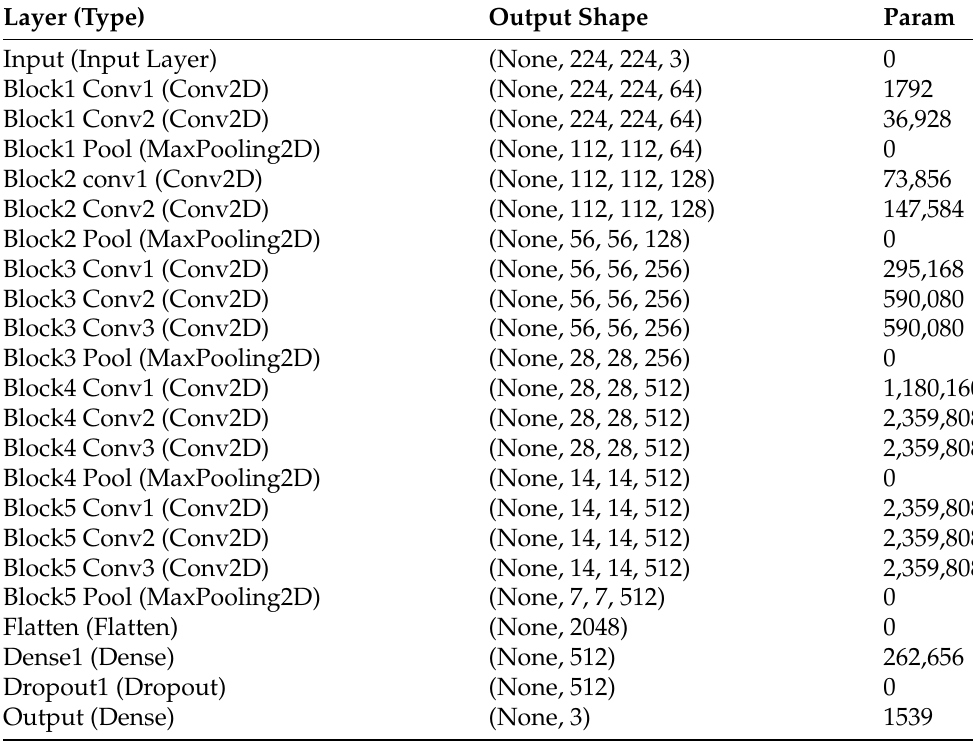
Table A3. Architecture of the CNN used based on